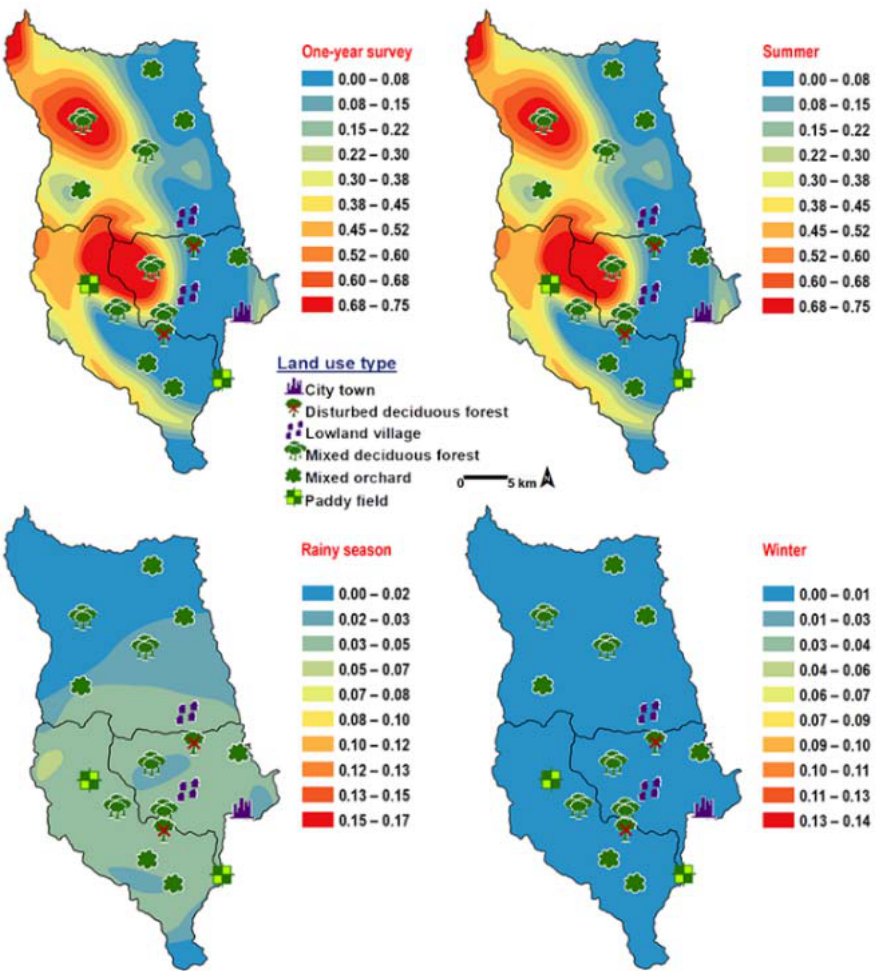
Figure 7. Predictive distribution maps of Ceylonomyia nigripes . The red areas symbolize the highest density of flies calculated by the analysis, while the blue areas indicate the lowest density. The scale corresponds to natural logarithm of (fly density +1).